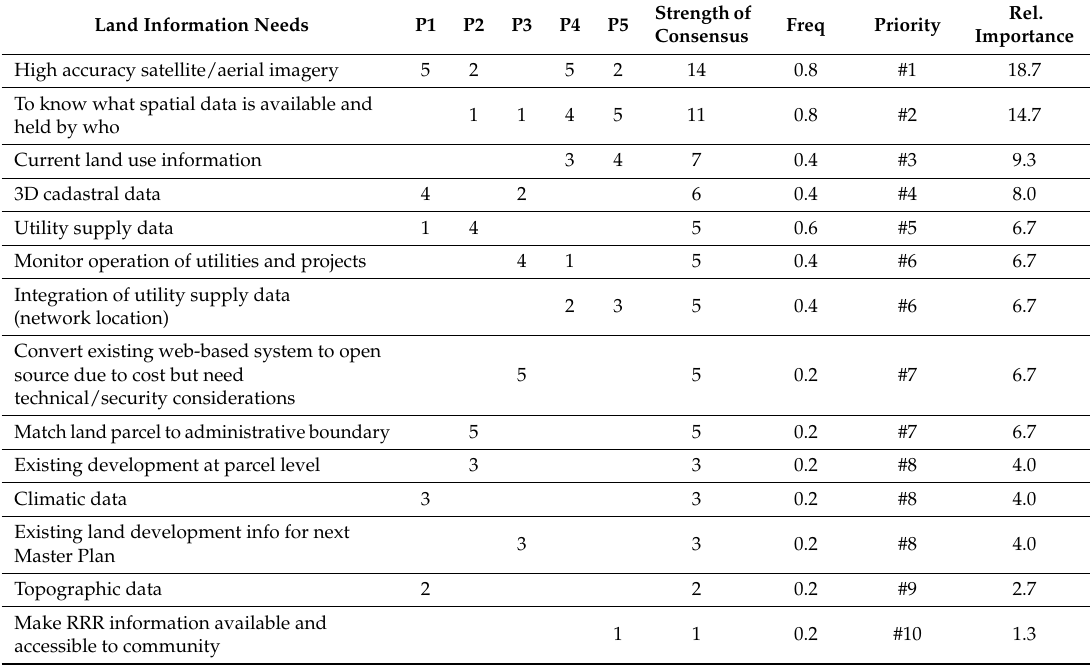
Table 4. Example of post-processed NGT